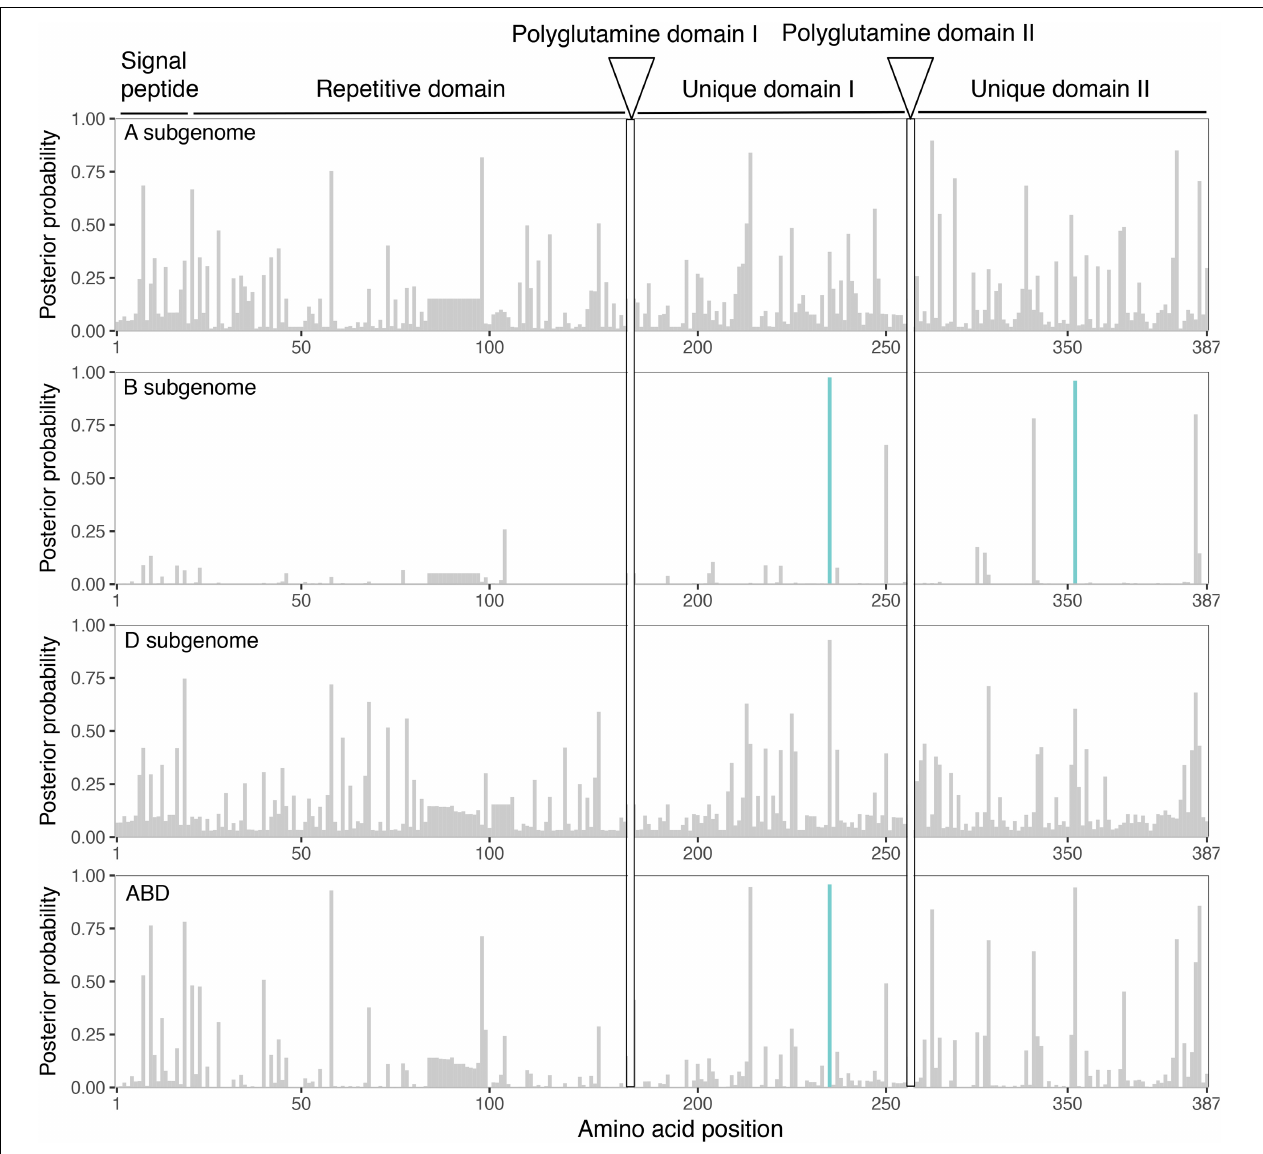
FIGURE 3 | Sites under positive selection in α -gliadin. Amino acids under selection were detected by estimating the ratio of non-synonymous (dN) to synonymous substitutions (dS) in each codon in the α -gliadin alignment for each subgenome. The panels show the Bayesian posterior probability of an amino acid site being under positive selection for the gliadin genes of each subgenome separately and the alignment of all three together (ABD). Highlighted in blue are the sites with a posterior probability > 95%. The different conserved domains (from Noma et al., 2016) are marked at the top of the panels. Sites that were difficult to align in the polyglutamine domains are